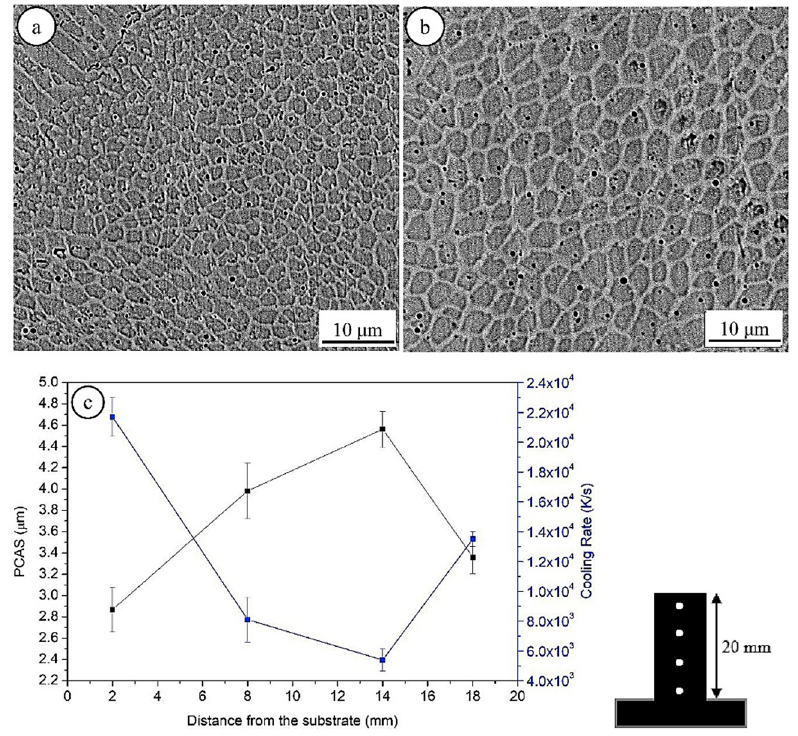
Figure 6. SEM images of DED AISI 316L at: ( a ) 2 mm, ( b ) 14 mm from the deposition/substrate interface, ( c ) primary cellular arm spacing (PCAS) and cooling rate as a function of the distance from the substrate [37].